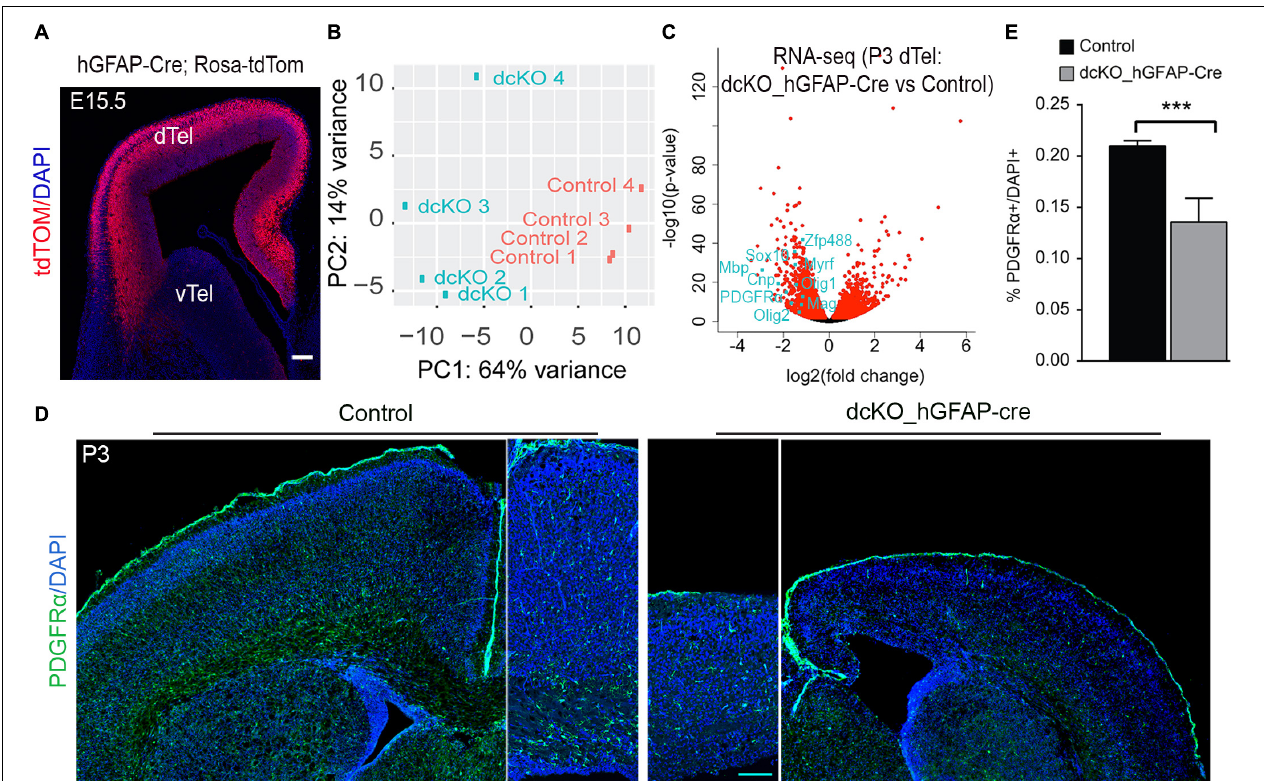
FIGURE 1 | Cortex-specific loss of BAF155 and BAF170 led to decreased number of OPCs in postnatal cortex. (A) Coronal brain sections of hGFAP-Cre, Rosa-tdTom transgenic mouse embryo revealing the cortex-specific hGFAP-Cre recombinase activity pattern at E15.5 (Nguyen et al., 2018). (B) Graph showing the variance distribution or clustering in a principal component (PC) analysis of the four control and four mutants P3 hGFAP-Cre dcKO cortices used for the RNA sequencing. In a principal analysis (C) Volcano plot showing the distribution of genes upregulated and downregulate in the P3 hGFAP-Cre dcKO cortices compared with control. Examples of key oligodendrogenesis-related genes downregulate in the BAF155 and BAF170 mutant cortex are indicated. (D) Immunostaining of PDGFR α (green) in coronal sections of control and dcKO_hGFAP-Cre brains at P3. (E) Quantitative analysis comparing the percentage of the PDGFR α + cells per total cortical cells (DAPI + ) in the control and hGFAP-Cre dcKO cortex at P3. Data are presented as means ± SEMs; *** p < 0.001; Experimental replicates ( n ) = 7. dTel, dorsal telencephalon; vTel, ventral telencephalon. Scale bars = 200 µ m (A , D)